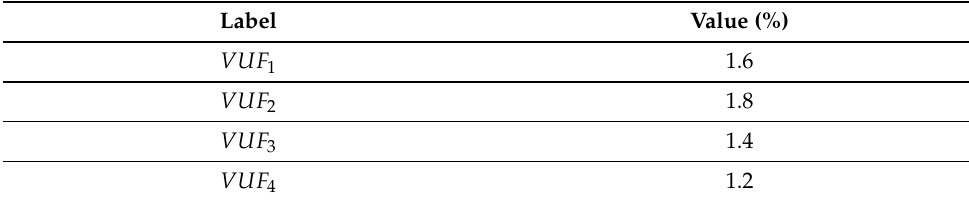
Table 2. VUF limits for the newly proposed volt/var control method.